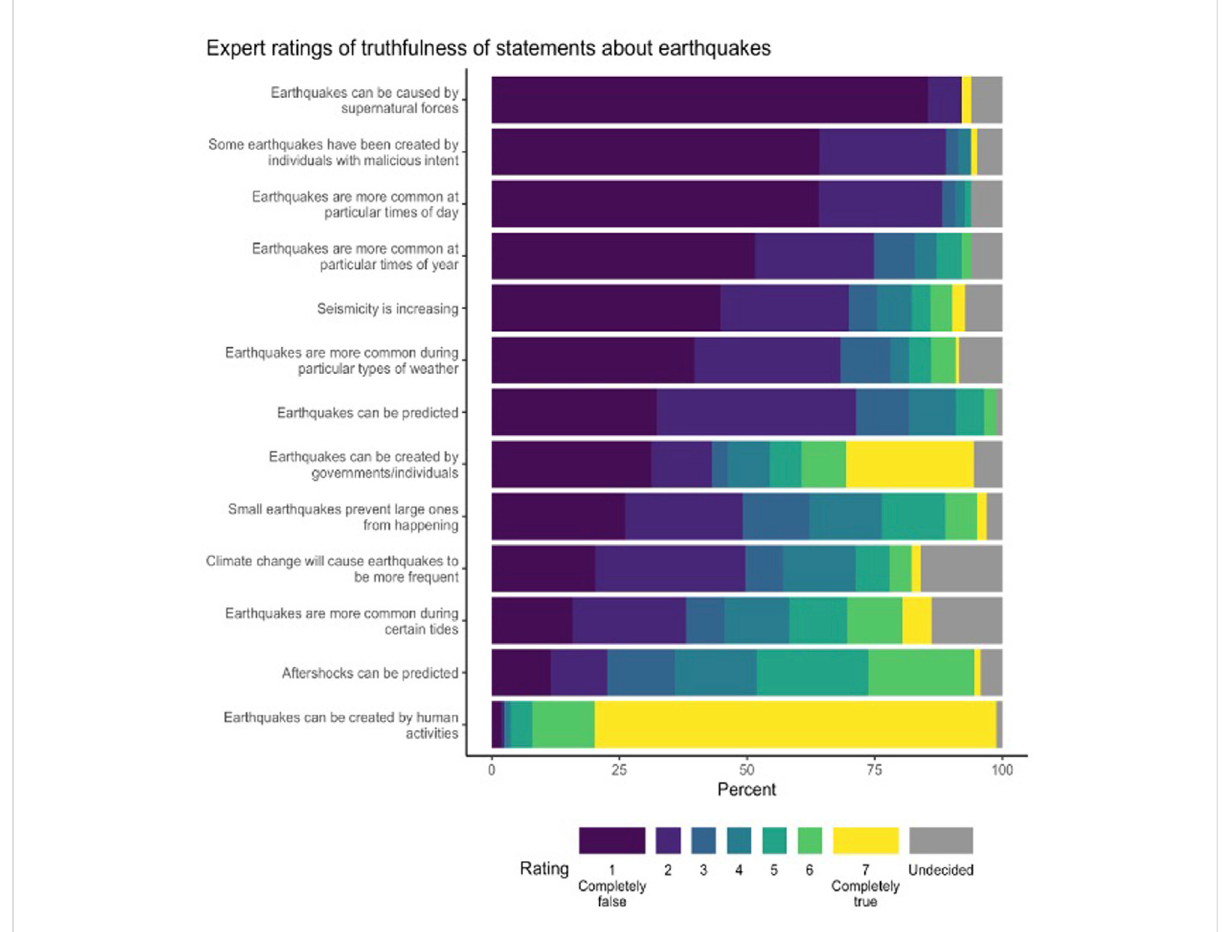
FIGURE 2 Proportion of participants choosing each rating of truth or falsehood for each statement in turn, from 1 = Completely false to 7 = Completely true, including in grey the proportion choosing “ Undecided ” . Statements are ordered by the proportion of participants choosing answer option 1 = Completely